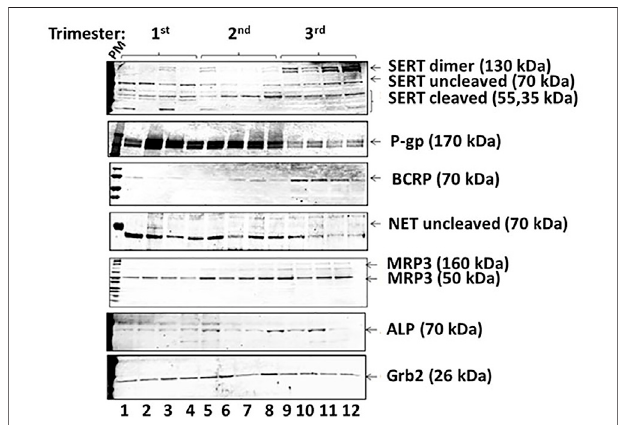
FIGURE4| ExemplarofWesternblotresultsfromplacentavesiclesfrom 1st, 2nd and 3rd trimesters ( n = 4 per trimester) for SERT and its isoforms, P-gp, BCRP, NET, MRP3, and ALP. Grb2 served as a loading control.